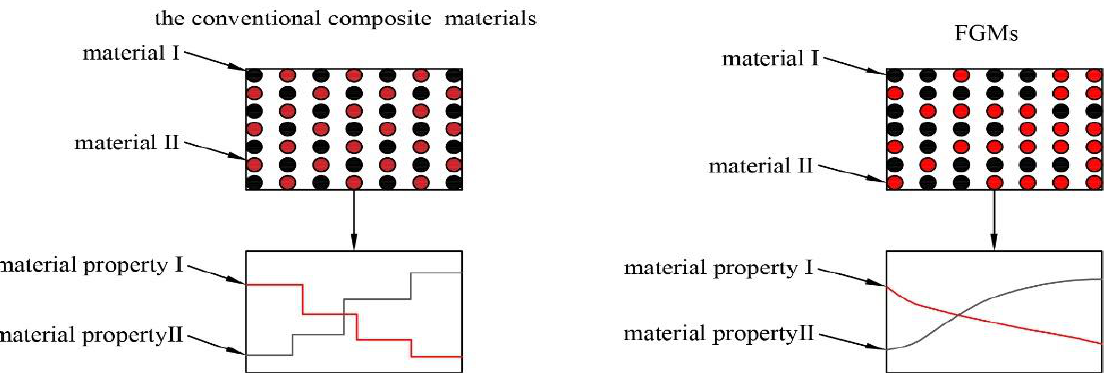
Figure 1. Variations of composition and properties in conventional composite materials and FGMs.